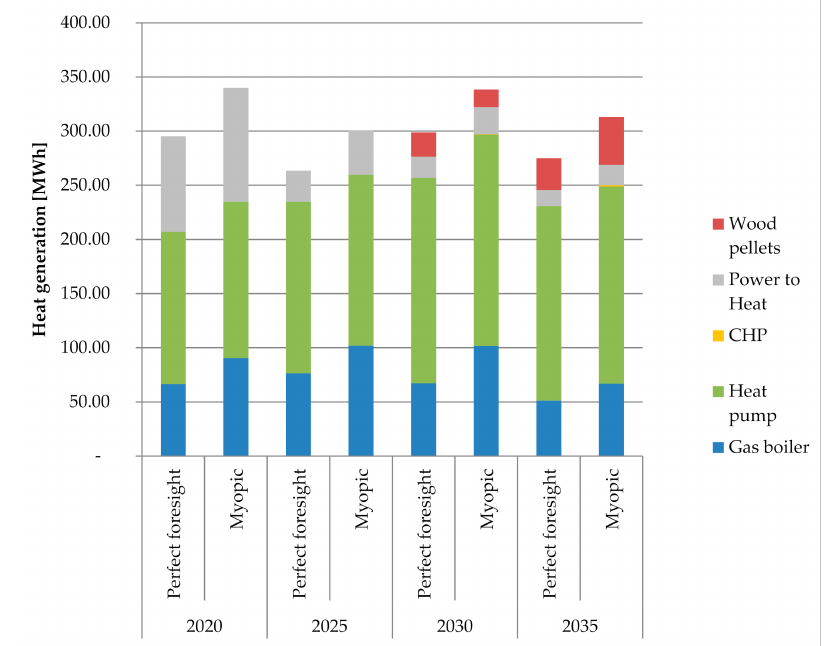
Figure 11. Heat generation in the RETRO scenario for the two expansion